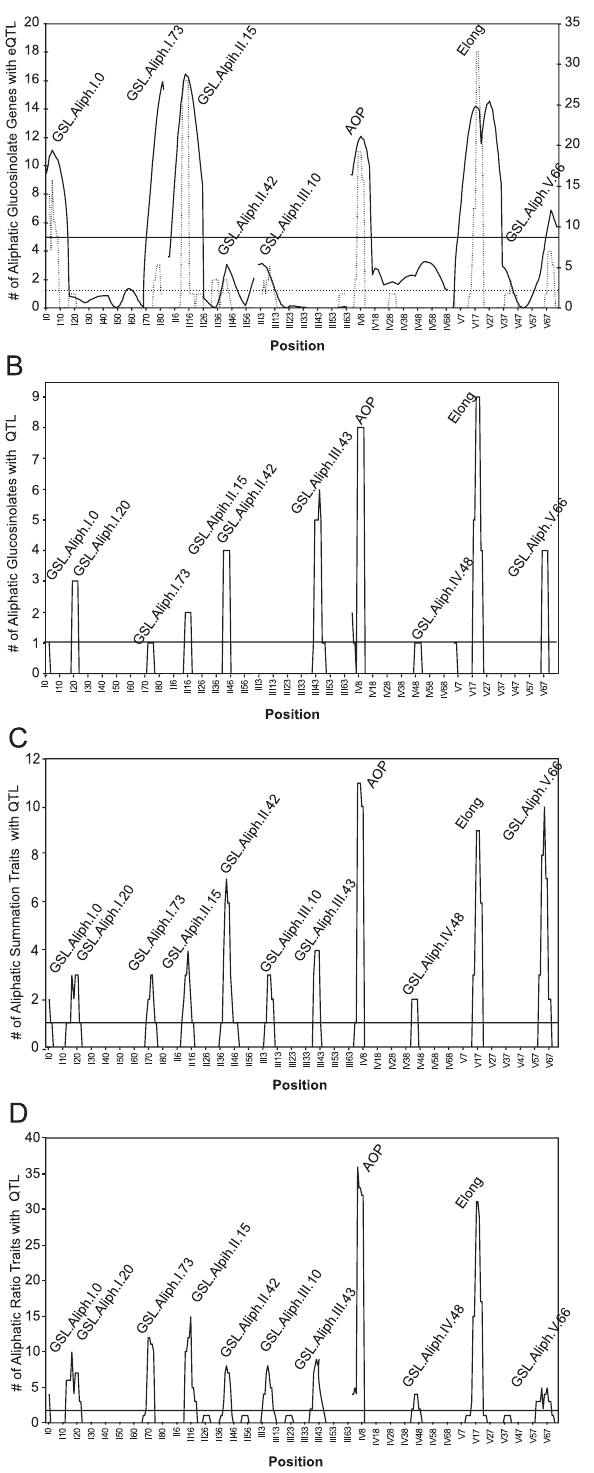
Figure 3. QTL Summary for Aliphatic Glucosinolates QTL position for aliphatic glucosinolate biosynthetic gene expression estimates and aliphatic glucosinolate metabolite accumulation is shown on the x- axis with the Roman numeral representing the chromosome number (I–V), while the arabic numeral shows the cM position on that chromosome. All five Arabidopsis chromosomes are represented contiguously. Names of the QTL positions that were shown by